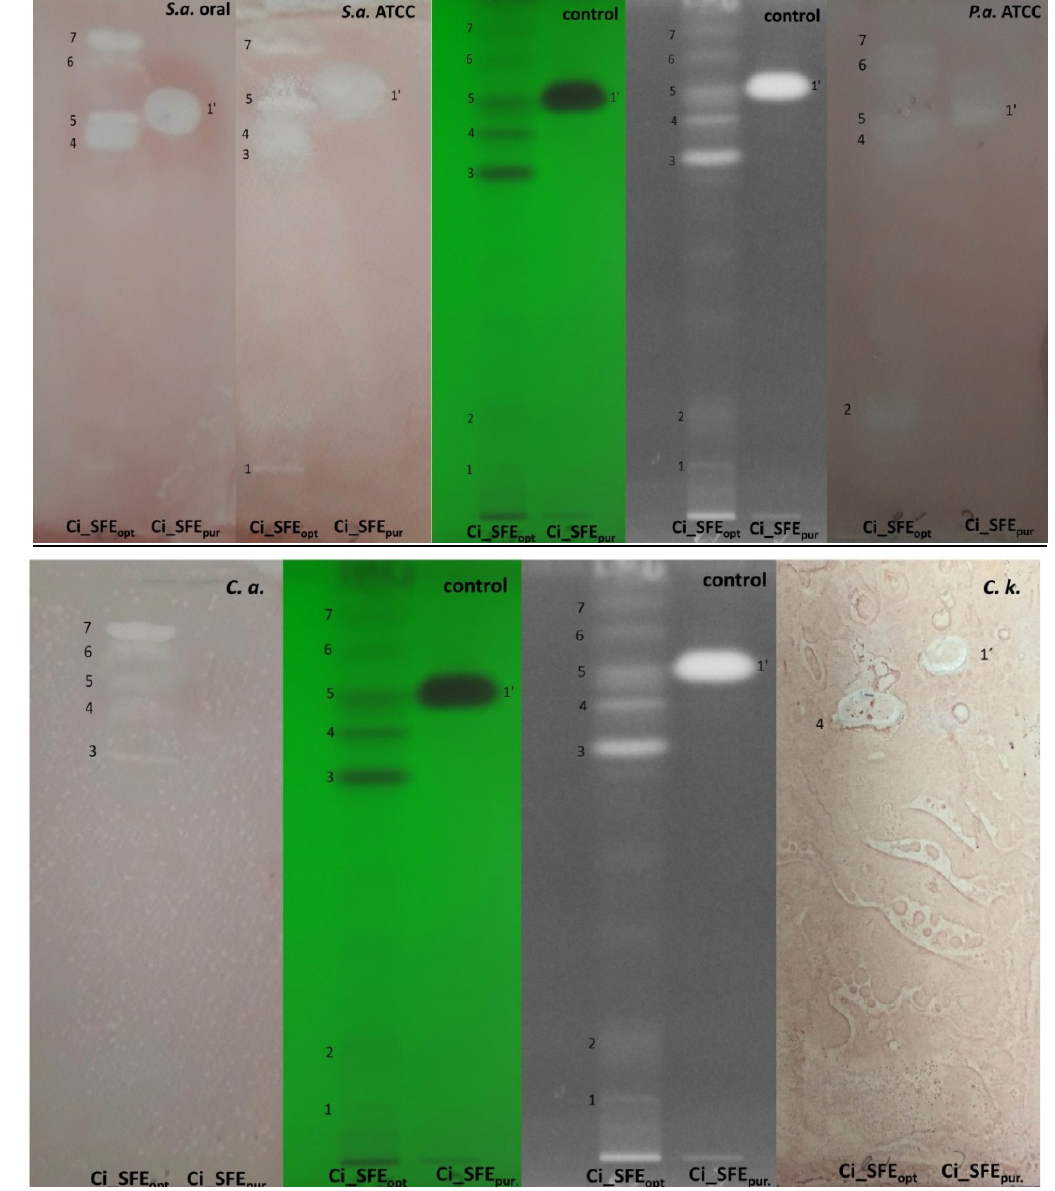
Figure 2. Bioautographic assay of Ci_SFEopt and Ci_SFEpur developed in 85:15 ( v/v ) dichloromethane:methanol as the solvent. ( A ) Antibacterial activity against Staphylococcus aureus (oral isolate), S. aureus ATCC (left); and Pseudomonas aeruginosa (right). ( B ) Antifungal activity against Candida albicans (left) and C. krusei (right). Spots on different Rf values: 1. Rf = 0.18 (activity only against S. aureus ATCC); 2. Rf = 0.20 (activity only against P. aeruginosa ); 3. Rf = 0.65 (activity against S. aureus ATCC and C. albicans ); 4. Rf = 0.71 (activity against all tested bacteria and fungi); 5. Rf = 0.76 (activity against all tested bacteria and fungi, except C. krusei ); 6. Rf = 0.82 (activity against all tested microorganisms, except P. aeruginosa and C. krusei ); 7. Rf = 0.88 (activity against all tested bacteria and fungi, except C. krusei ).